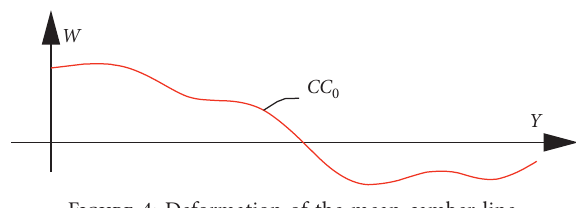
Figure 4: Deformation of the mean camber line.